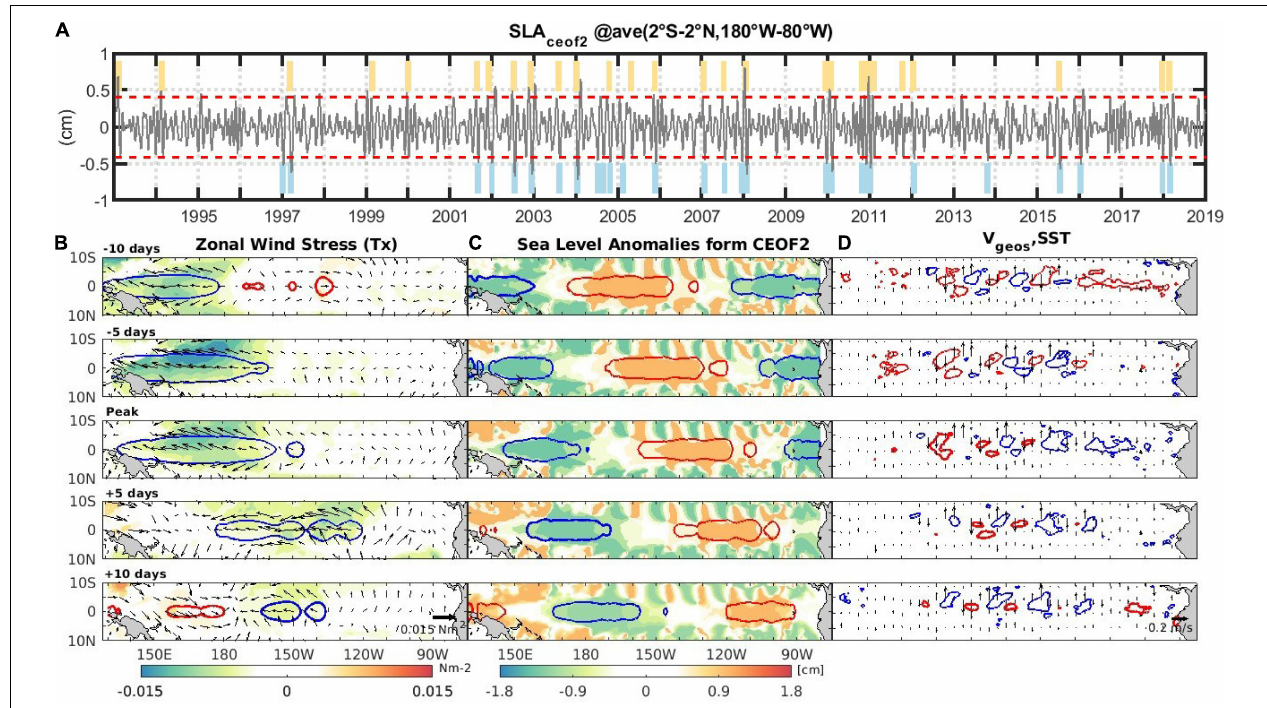
FIGURE 2 | (A) SLA reconstructed from CEOF2 and averaged in the region (2 ◦ S–2 ◦ N, 180 ◦ W–80 ◦ W). SLA events above (below) 2 standard deviations are highlighted in yellow (blue). ( B , left panels) Composites of the corresponding intraseasonal wind stress anomalies (in Nm - 2 ) reconstructed from the first EOF mode at different leads/lags (centered, i.e., lag 0, at the SLA peak from A ). The colored contours represent the intraseasonal zonal wind stress anomalies projected onto the theoretical Kelvin wave meridional structure; blue (red) contours correspond to -0.002 Nm - 2 (+ 0.002 Nm - 2 ). ( C , middle panels) Composites (shading in cm) of SLA reconstructed from CEOF2 at different leads/lags (in days) indicated on the top left of the leftmost panels and centered (i.e., lag 0) during the strong positive intraseasonal equatorial sea level anomalies events identified in (A) (i.e., the IKWs downwelling phases). The colored contours represent the intraseasonal SLA projected onto the theoretical Kelvin wave meridional structure; blue (red) contours are for values of -0.5 (+ 0.5) cm. ( D , right panels) Composites of meridional geostrophic velocity anomalies (arrows), and SST anomalies [red (blue) contours corresponds to 0.2 (-0.2) ◦